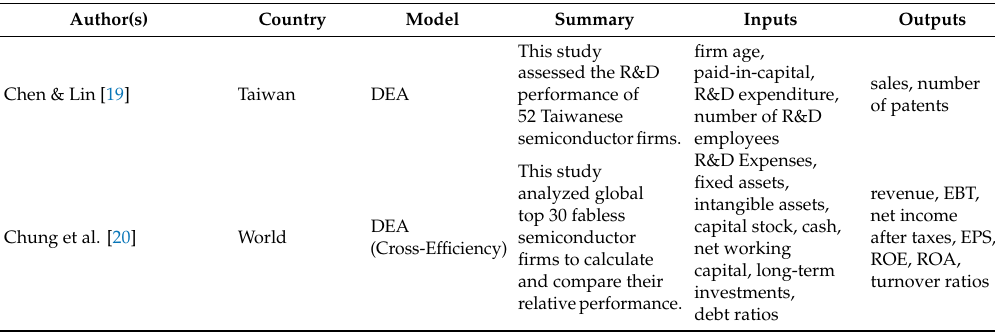
Table 2. Data envelopment analysis (DEA) studies applied to semiconductor